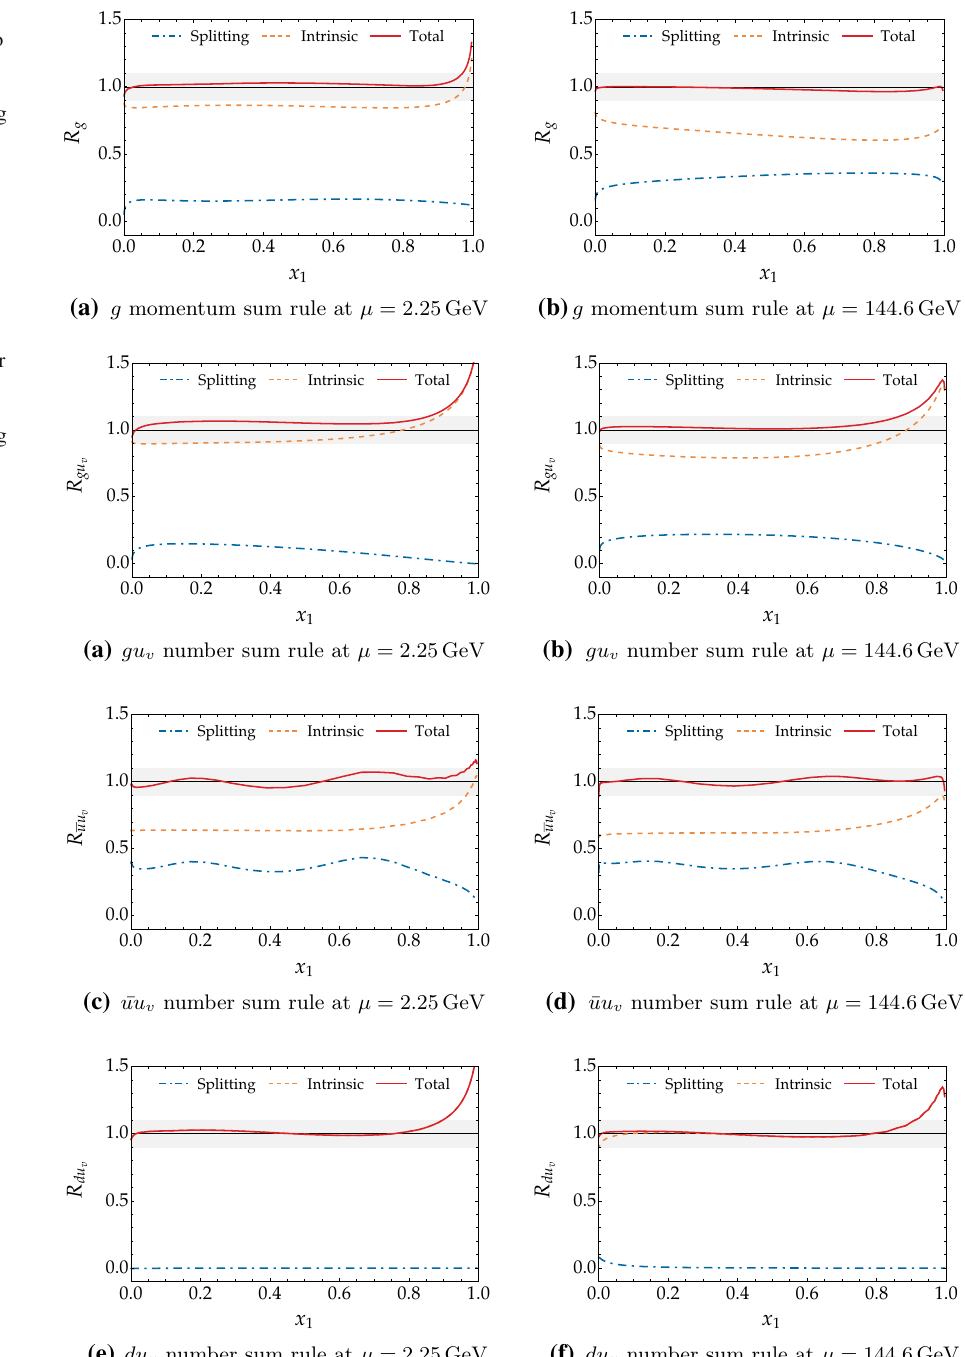
Splitting Intrinsic